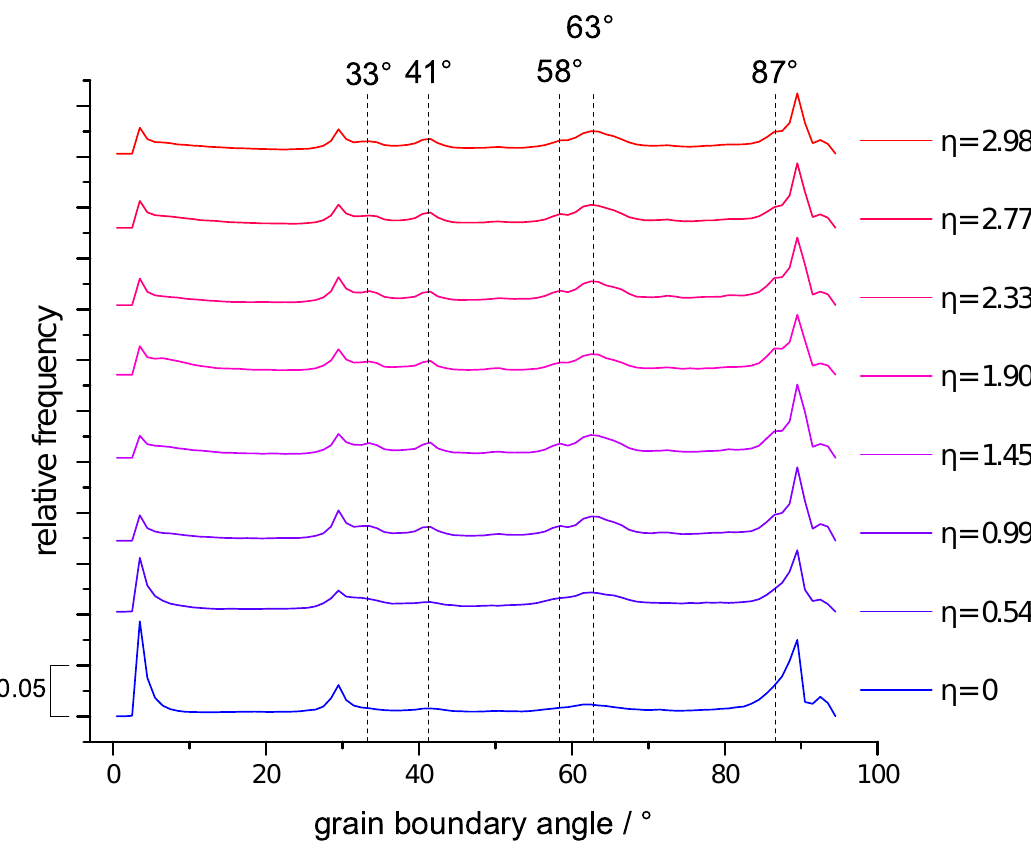
Figure 6. Relative frequency of misorientation angle in